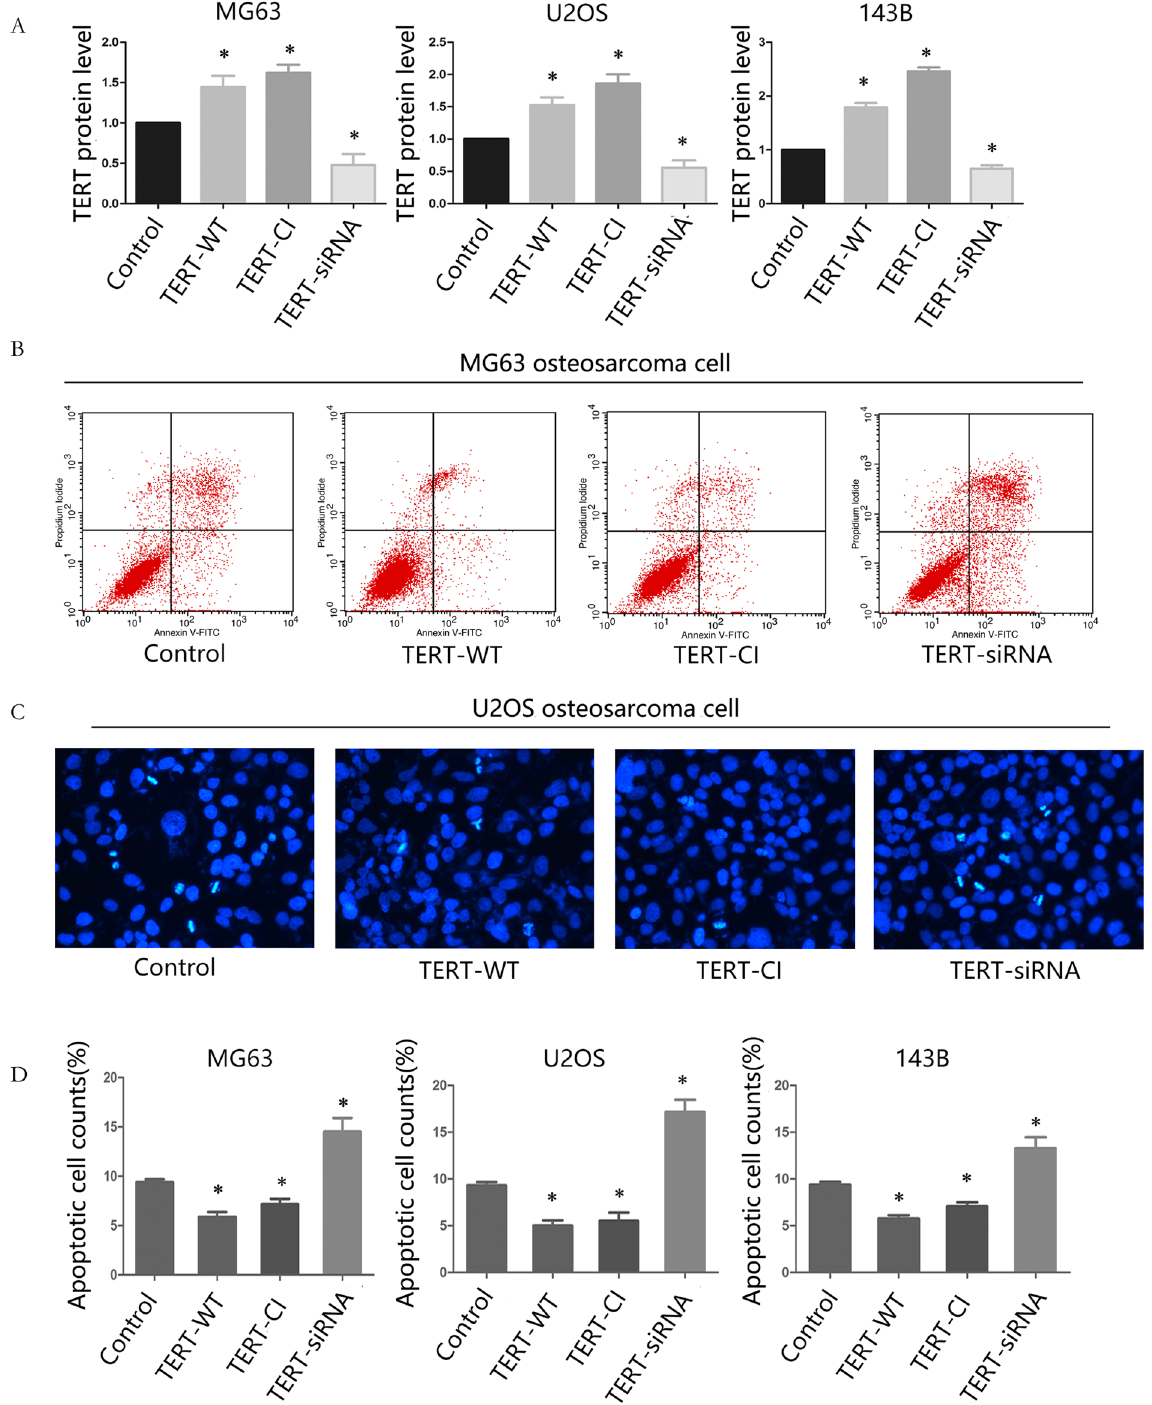
Figure 2. TERT reduces apoptosis induced by cisplatin in osteosarcoma cells independently of telomerase reverse transcriptase activity. ( A ) The relative TERT expression in mock transfected cells (control), TERT- overexpressing cells (TERT-WT, TERT-CI) and TERT-siRNA cells were assessed by Western blot analysis. ( B ) MG63 transfected cells were treated with 5 μ mol/L cisplatin for 24 hours after which the apoptosis in cells was detected by flow cytometry. ( C ) U2OS transfected cells were treated wit with 5 μ mol/L cisplatin for 24 hours after which the apoptosis in cells was assessed by Immuno-fluorescence. Karyopyknosis is taken as apoptosis. ( D ) Quantification of apoptotic rate in cisplatin-treated osteosarcoma transfected cell lines detected by FACS. All experiments were carried out at least triplicates and the data were presented as the mean ± S.D. Student t test was performed to evaluate the difference * P <